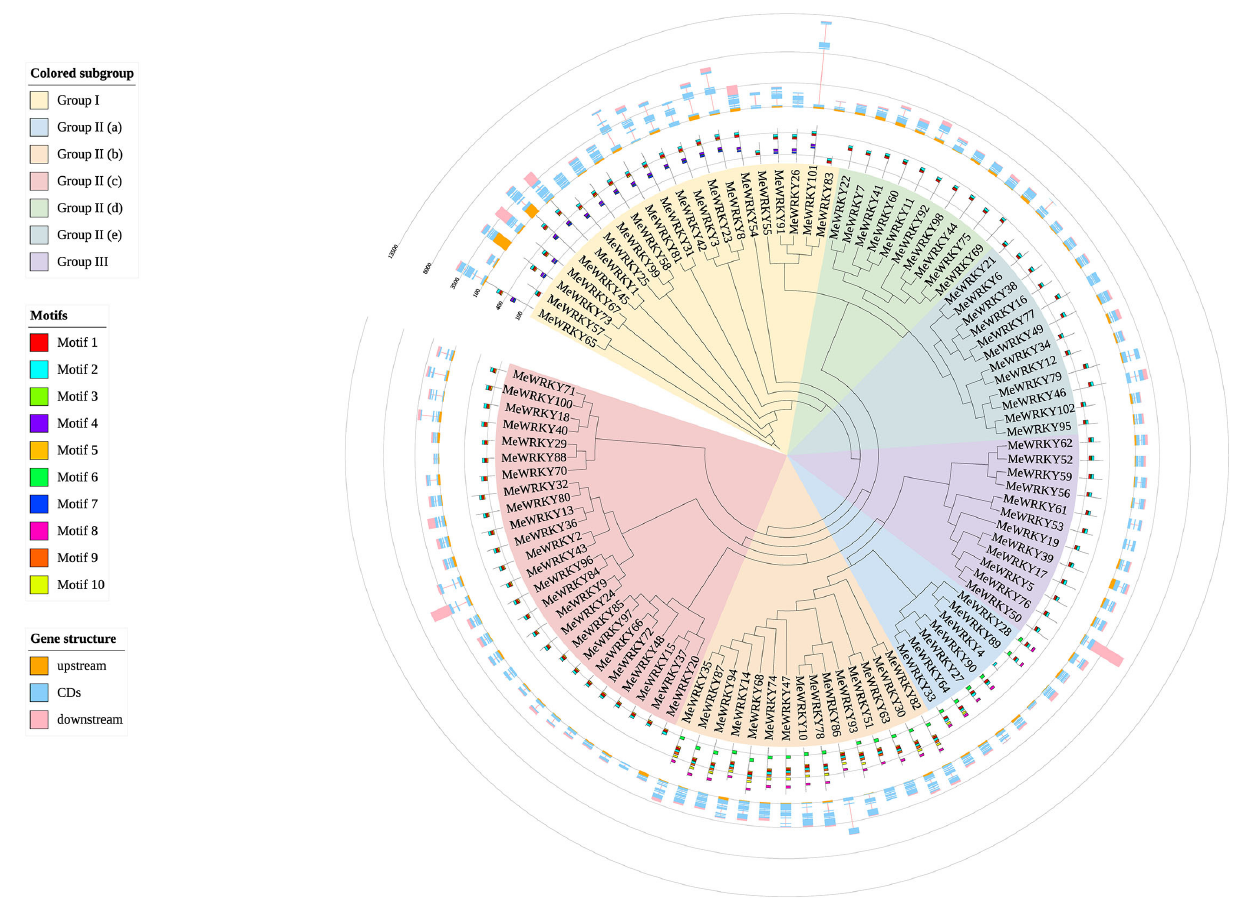
FIGURE 2 | Phylogenetic tree, gene structure, and conserved motifs of 102 MeWRKYs generated from the amino acid sequences with WRKY domains from cassava. The neighbor-joining tree was constructed using MEGA 7.0 with 1,000 bootstraps. The middle circle shows the conserved motifs of the 102 MeWRKYs. The outermost circle shows the exon–intron gene structure of 102